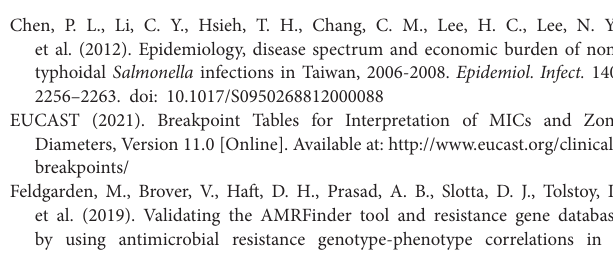
Supplementary Figure S1 | The resistance rates for ceftriaxone, chloramphenicol, ciprofloxacin, levofloxacin, ampicillin, and SMZ in different age of children, p <0.05 was